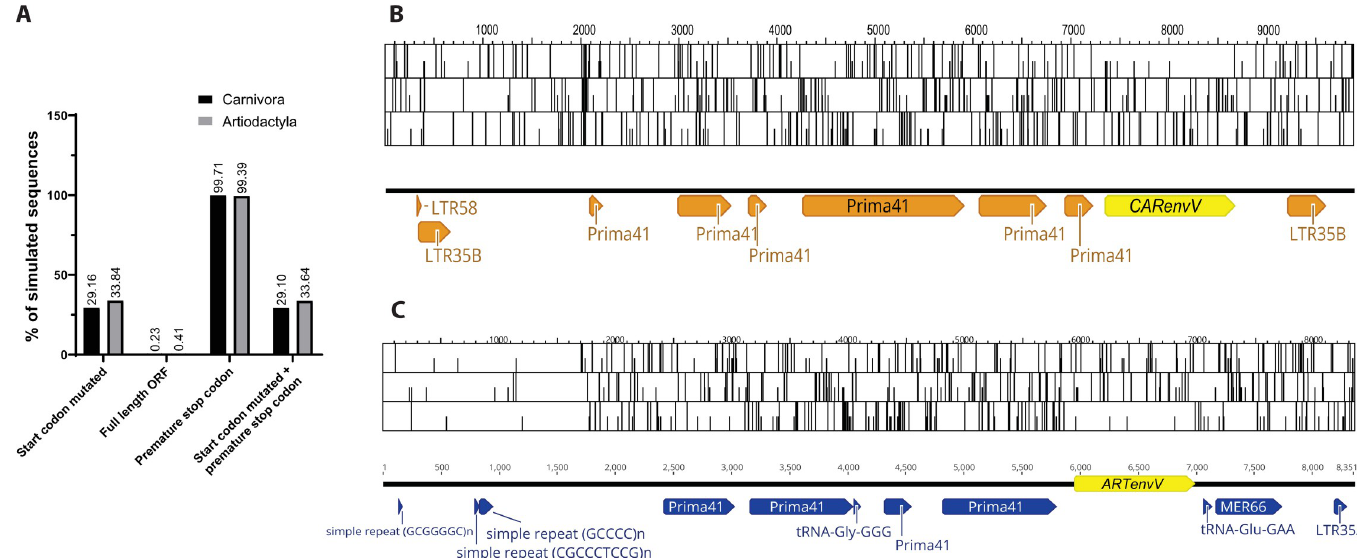
Fig 8. Preservation of CARenvV and ARTenvV ORF under neutral evolution. A. Results of the Monte-Carlo simulations of CARenvV and ARTenvV evolution for 54 and 64 million years are shown, respectively, using the mammalian neutral substitution rate. The percentage of 100,000 simulated sequences that have the indicated properties are plotted. B. ORF map of the CARenvV ERV with all three forward reading frames is shown. CARenvV ORF is annotated in yellow and the Dfam designation of repeat elements is indicated in orange. C. ORF map of the ARTenvV ERV with all three reading frames is shown. ARTenvV ORF is annotated in yellow and the Dfam designation of repeat elements is indicated in blue. Potential start codons are indicated with a half-height line and stop codons are indicated with a full height line.